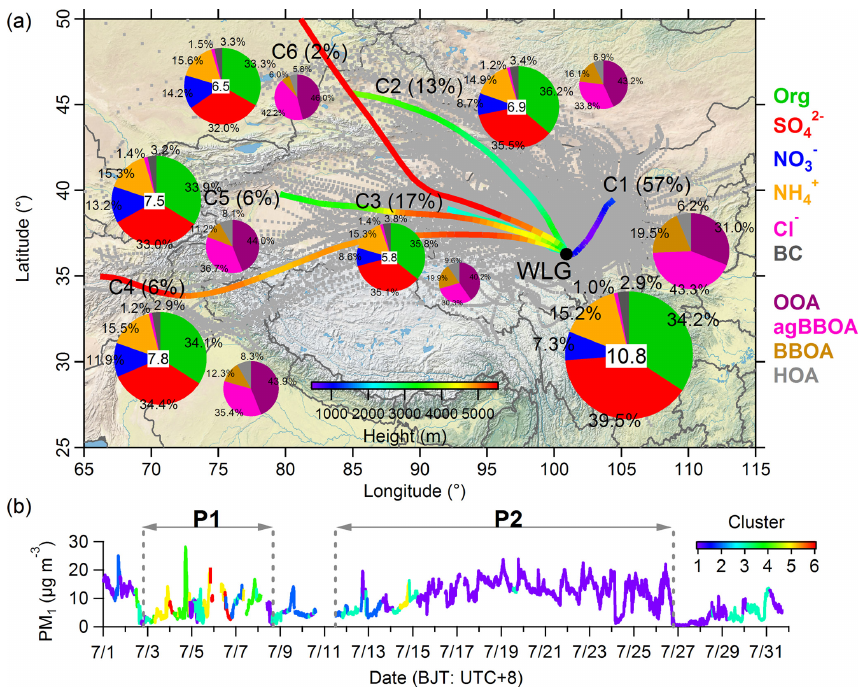
Figure 7. (a) The 72h backward air mass trajectories (gray dotted lines) and average trajectory clusters (solid lines colored according to height) calculated at 1h intervals for the entire study period. Pie charts show the average mass contributions of PM 1 species to total PM 1 (average PM 1 mass values are marked in the center of the pie charts) and OA components to total organics belong to each cluster (areas of pie charts are scaled by the corresponding average mass). (b) Temporal variation of PM 1 mass concentration colored by the corresponding cluster name in this study. The markers of P1 and P2 represent two different periods that selected in this